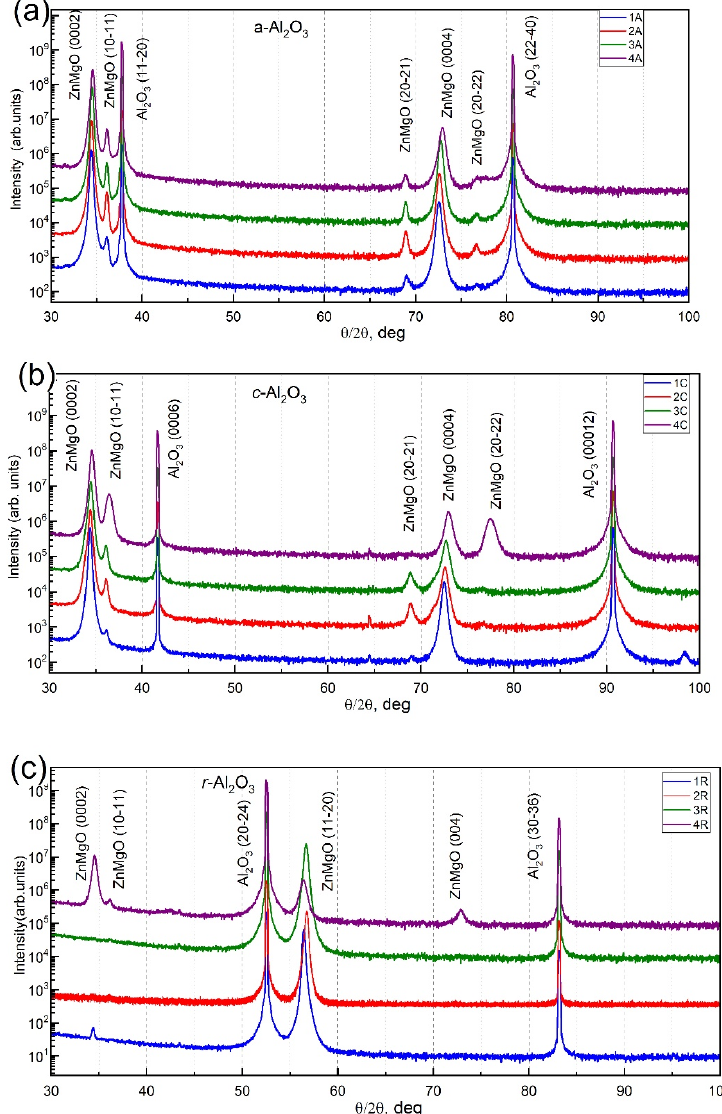
Figure 2. Theta–2Theta XRD patterns of the Zn 1 − x Mg x O:Sb layers ( a ) on a ‐ Al 2 O 3 ( b ) on c ‐ Al 2 O 3 ( c ) on r ‐ Al 2 O 3 .